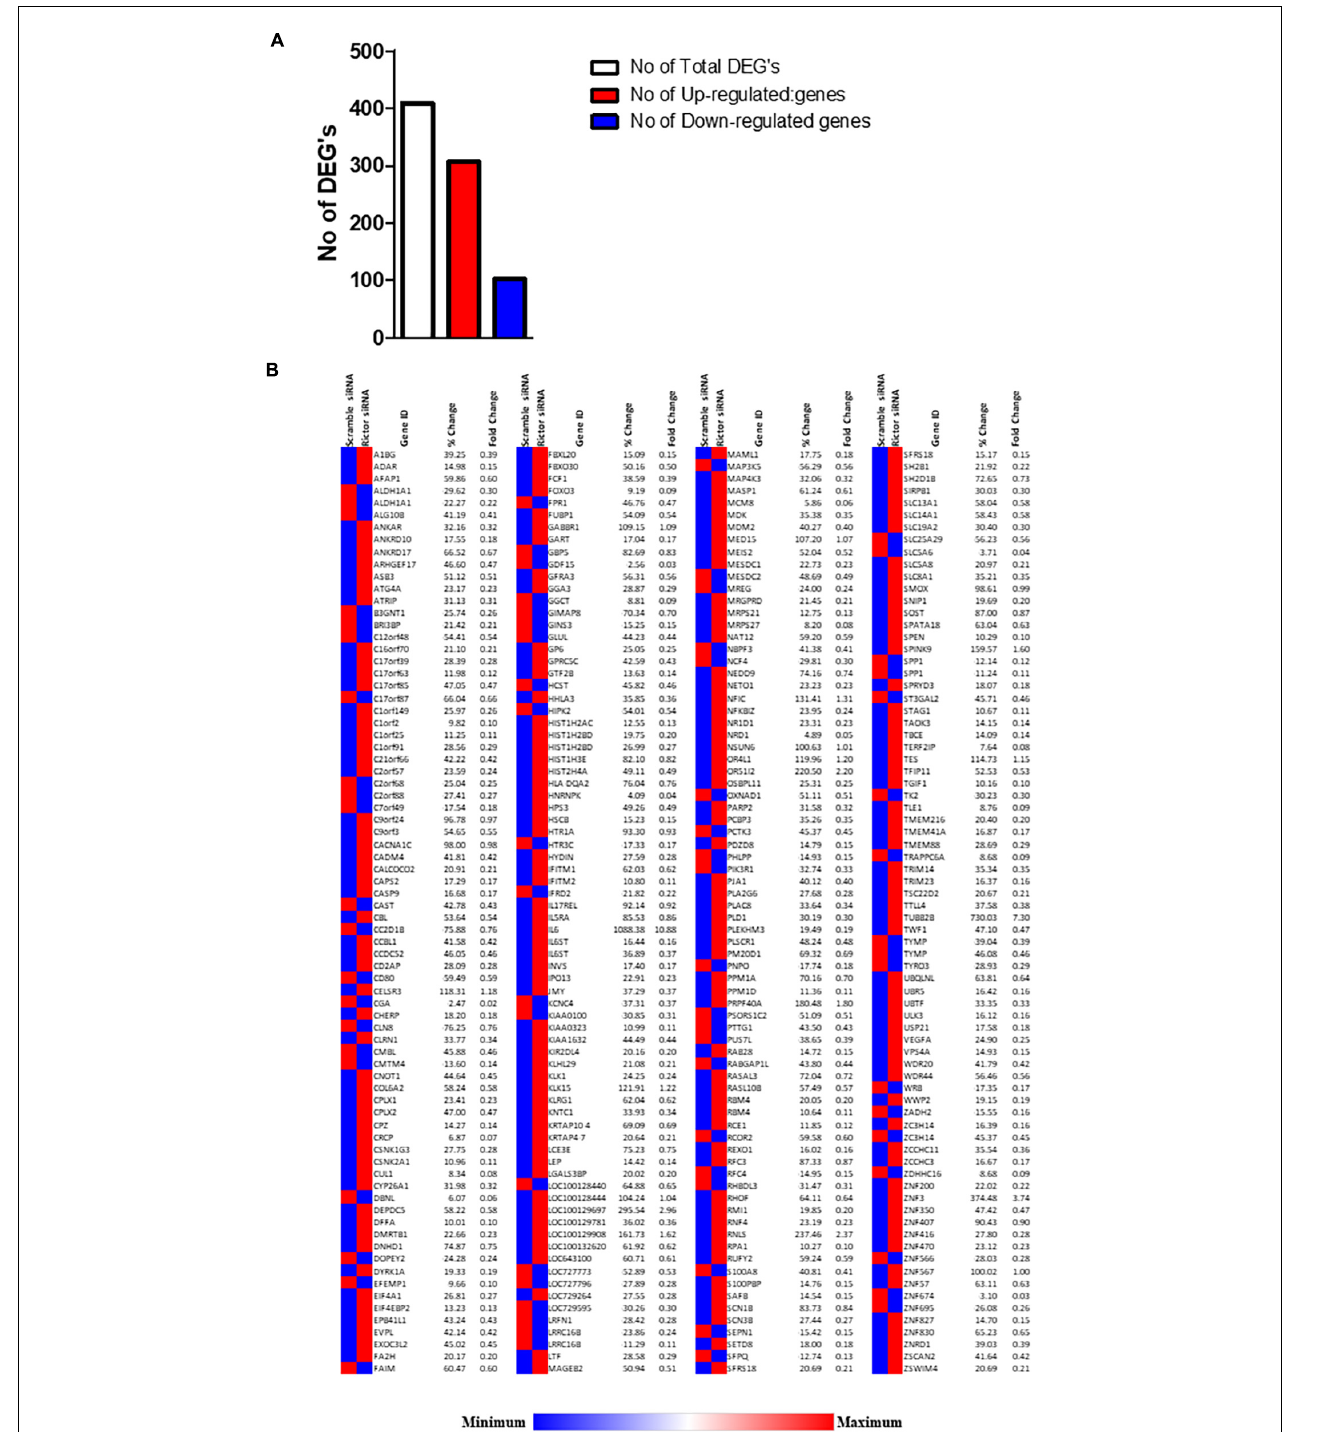
FIGURE 2 | Differentially expressed genes in rictor siRNA vs. scramble siRNA silenced PHT cells. (A) The number of differentially expressed genes in rictor siRNA vs. scramble siRNA silenced PHT cells. The red represents up-regulated genes and blue represents down-regulated genes in rictor silenced PHT cells as compared to cells transfected with scramble siRNA. (B) Heatmap of expression data for the differentially expressed genes in rictor siRNA vs. scramble siRNA silenced PHT cells. Color index represents gene expression changes, the red represents up-regulated genes, and the blue represent down-regulated genes in rictor silenced PHT cells as compared to cells transfected with scramble